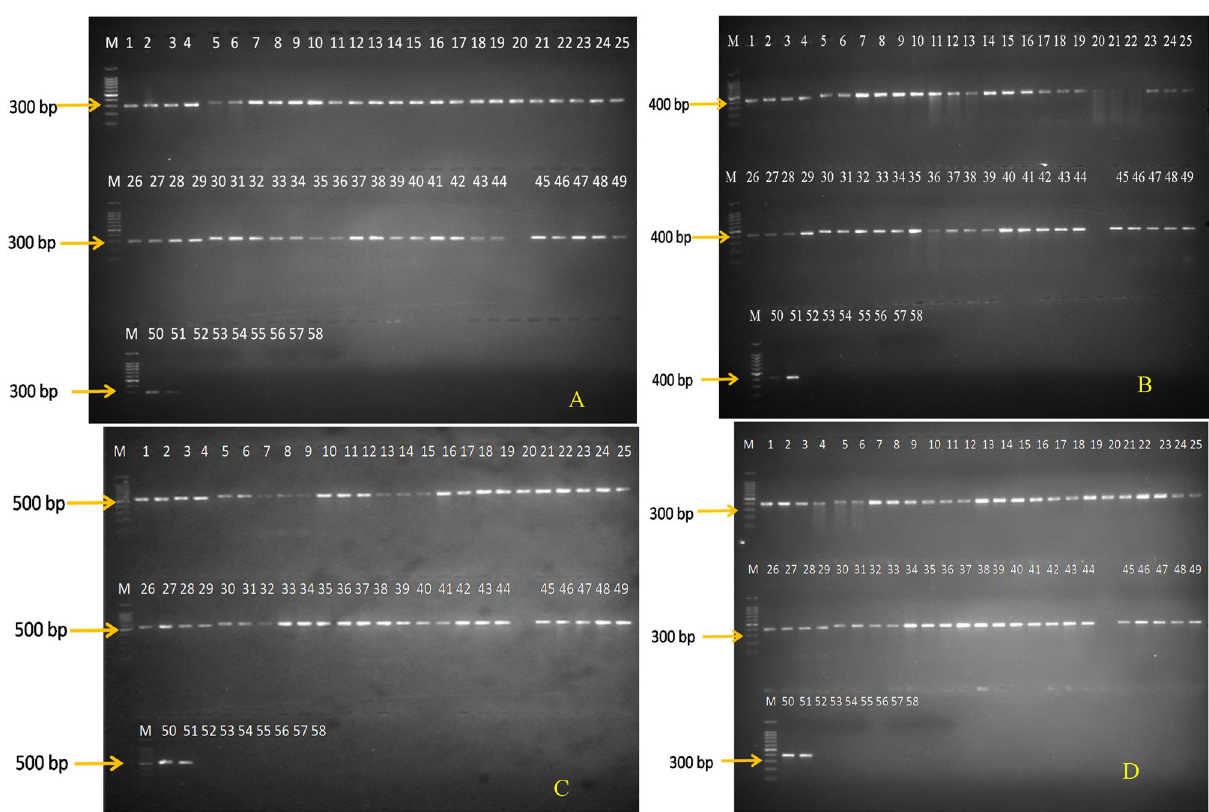
Figure 1. (A) PCR amplification using primer pair RSPG1Fand RSPG1R showing amplification product of 300 bp. (B) PCR amplification using primer pair RSPG2F and RSPG2R showing amplification product of 375 bp. (C) PCR amplification using primer pair RSPG4F and RSPG4R showing amplification product of 500 bp. (D) PCR amplification using primer pair RSPG5F and RSPG5R showing amplification product of 336 bp. Lane M is a 100-bp DNA marker. Lanes 1–51 represent different Rhizoctonia solani AG-1 IA strains; while lanes 52–58 are S. sclerotiorum , T. viride, F. oxyporum , A. alternata , C. capsici, B. subtilis, and P. plecoglossicida respectively. All DNA were extracted from fungal